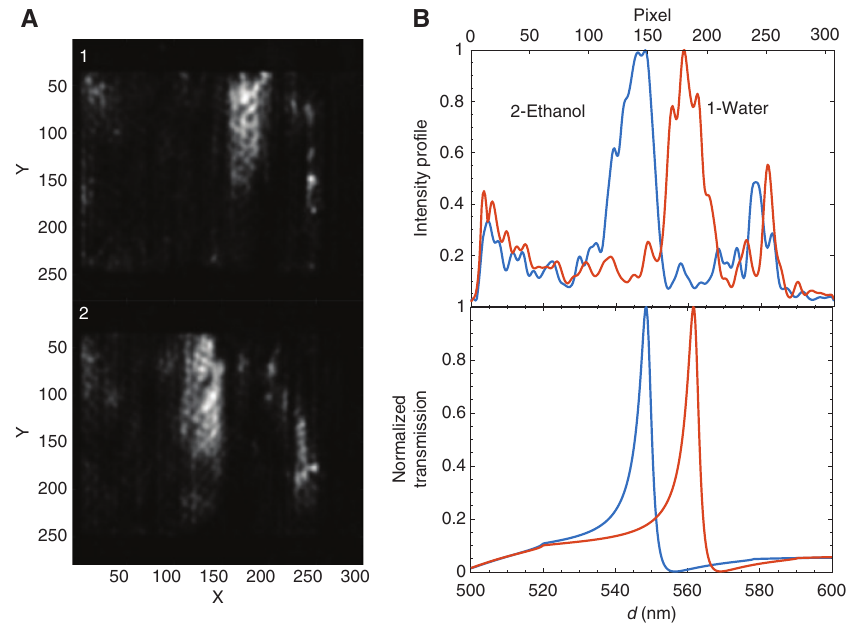
Figure 4: Sensitivity measurements. Transmission image of the multiperiodic nanohole array sample with (1) water and (2) ethanol as the surrounding medium. (B) Top Measured transmission profile of the images of the arrays. The intensity was integrated along the y-axis and plotted as a function of the x-axis. Bottom: Transmission intensity of the nanohole array as a function of the period as calculated using coupled mode theory.